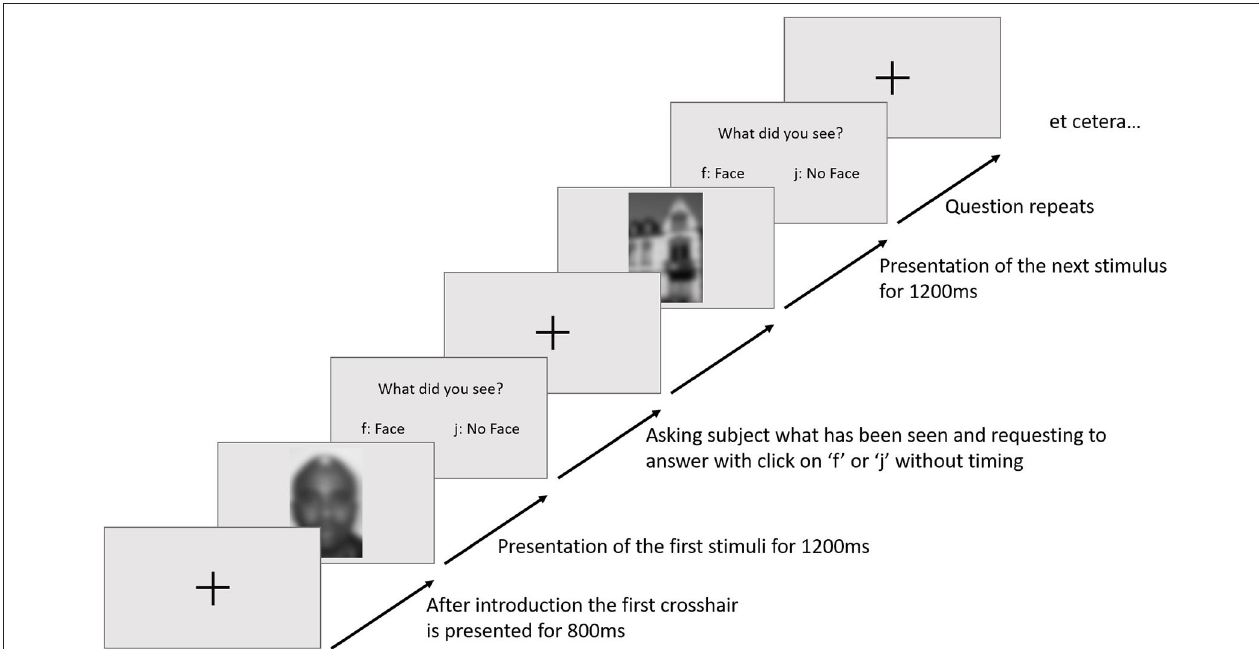
FIGURE 1 | An example of a trial sequence. Blurred images for privacy.